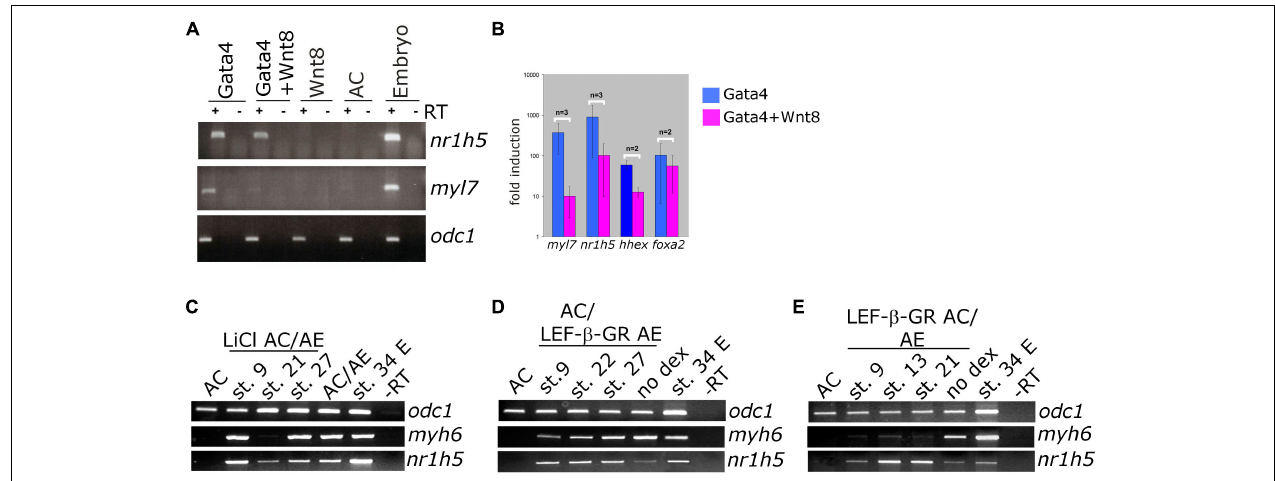
FIGURE 4 | Differential effect of Wnt/beta catenin signaling activation on cardiac and liver cell fate. (A) Animal caps co-injected with Gata4 mRNA and Wnt8-expressing DNA show marked reduction of myl7 RNA levels and negligible effect on nr1h5 expression. (B) qPCR analysis confirms the findings of gel RT-PCR for myl7 and nr1h5 and in addition shows the reduction of hhex expression in Gata4 + Wnt8 samples. (C) AC/AE conjugates were treated with LiCl at indicated stages. Treatment at st. 21 blocked cardiac differentiation but had a lesser effect on liver specification. (D) Cell autonomous activation of Wnt/ β -catenin signaling in LEF- β -GR mRNA-injected AE was achieved by adding dexamethasone (dex) to AC/AE conjugates at indicated stages. No effect on either heart or liver marker expression was observed. (E) In contrast, activation of LEF- β -GR in the AC part of the conjugates greatly reduced myh6 expression without affecting nr1h5 . Explants were collected for RT-PCR analysis when sibling embryo controls reached st.